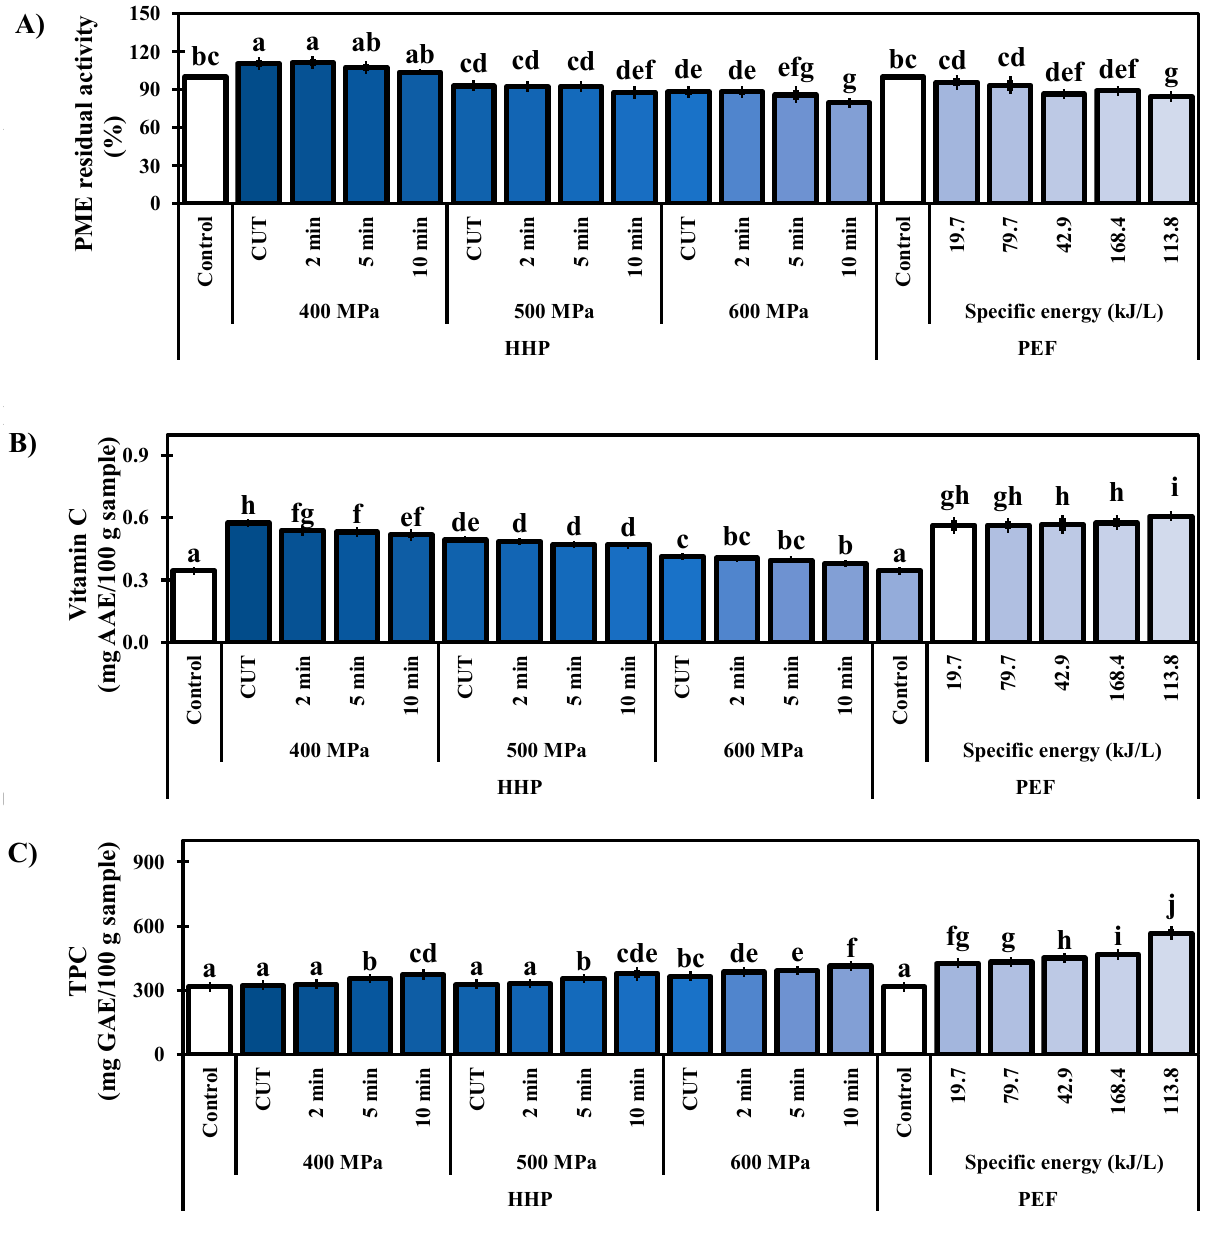
Figure 1. Effect of the HHP and PEF treatments to pasteurize black/red raspberry juice. ( A ) Inactiva- tion of PME, ( B ) Vitamin C, and ( C ) TPC. Mean value ± standard deviations ( n = 9). The values with different superscript letters are statistically different ( p < 0.05).